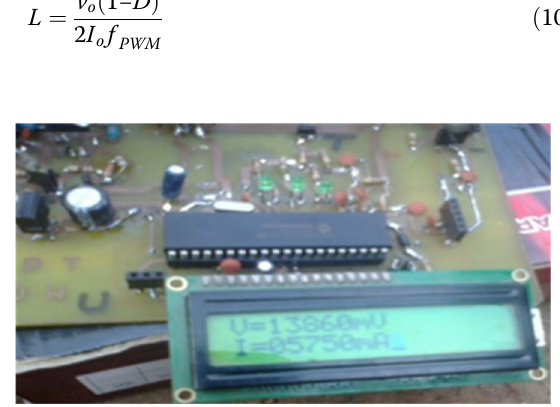
Fig. 6 Picture of the designed MPPT Fig. 7 Value of output Voltage and Current on LCD